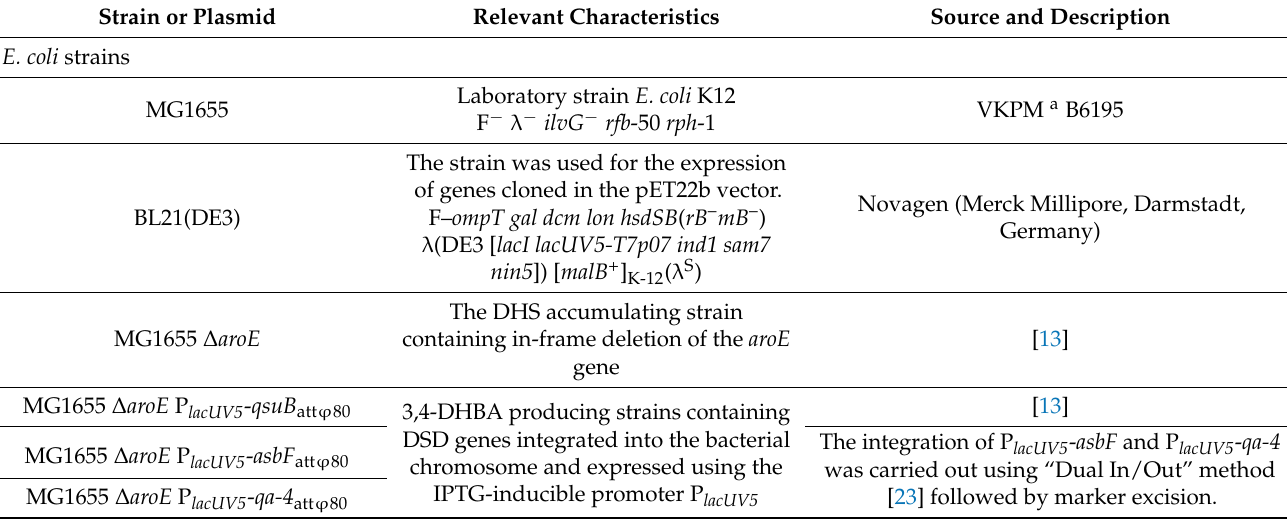
Table 1. E. coli strains and plasmids used in this work.